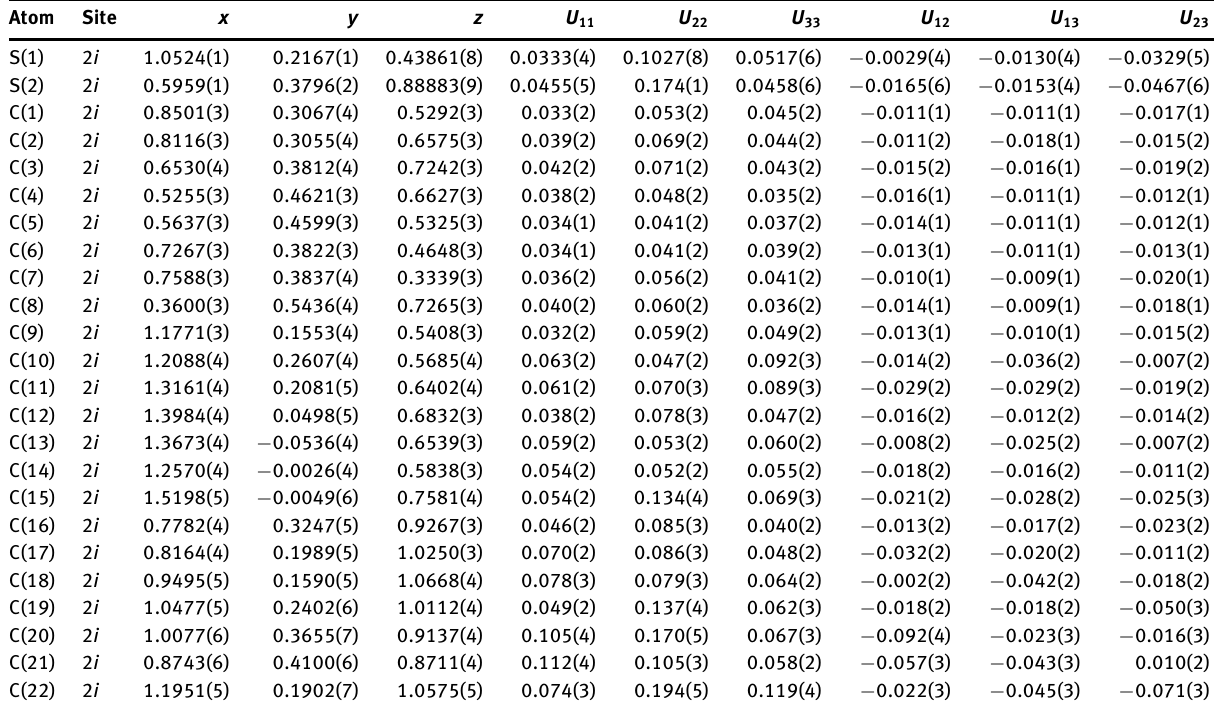
Table 3: Atomic displacement parameters (Å 2